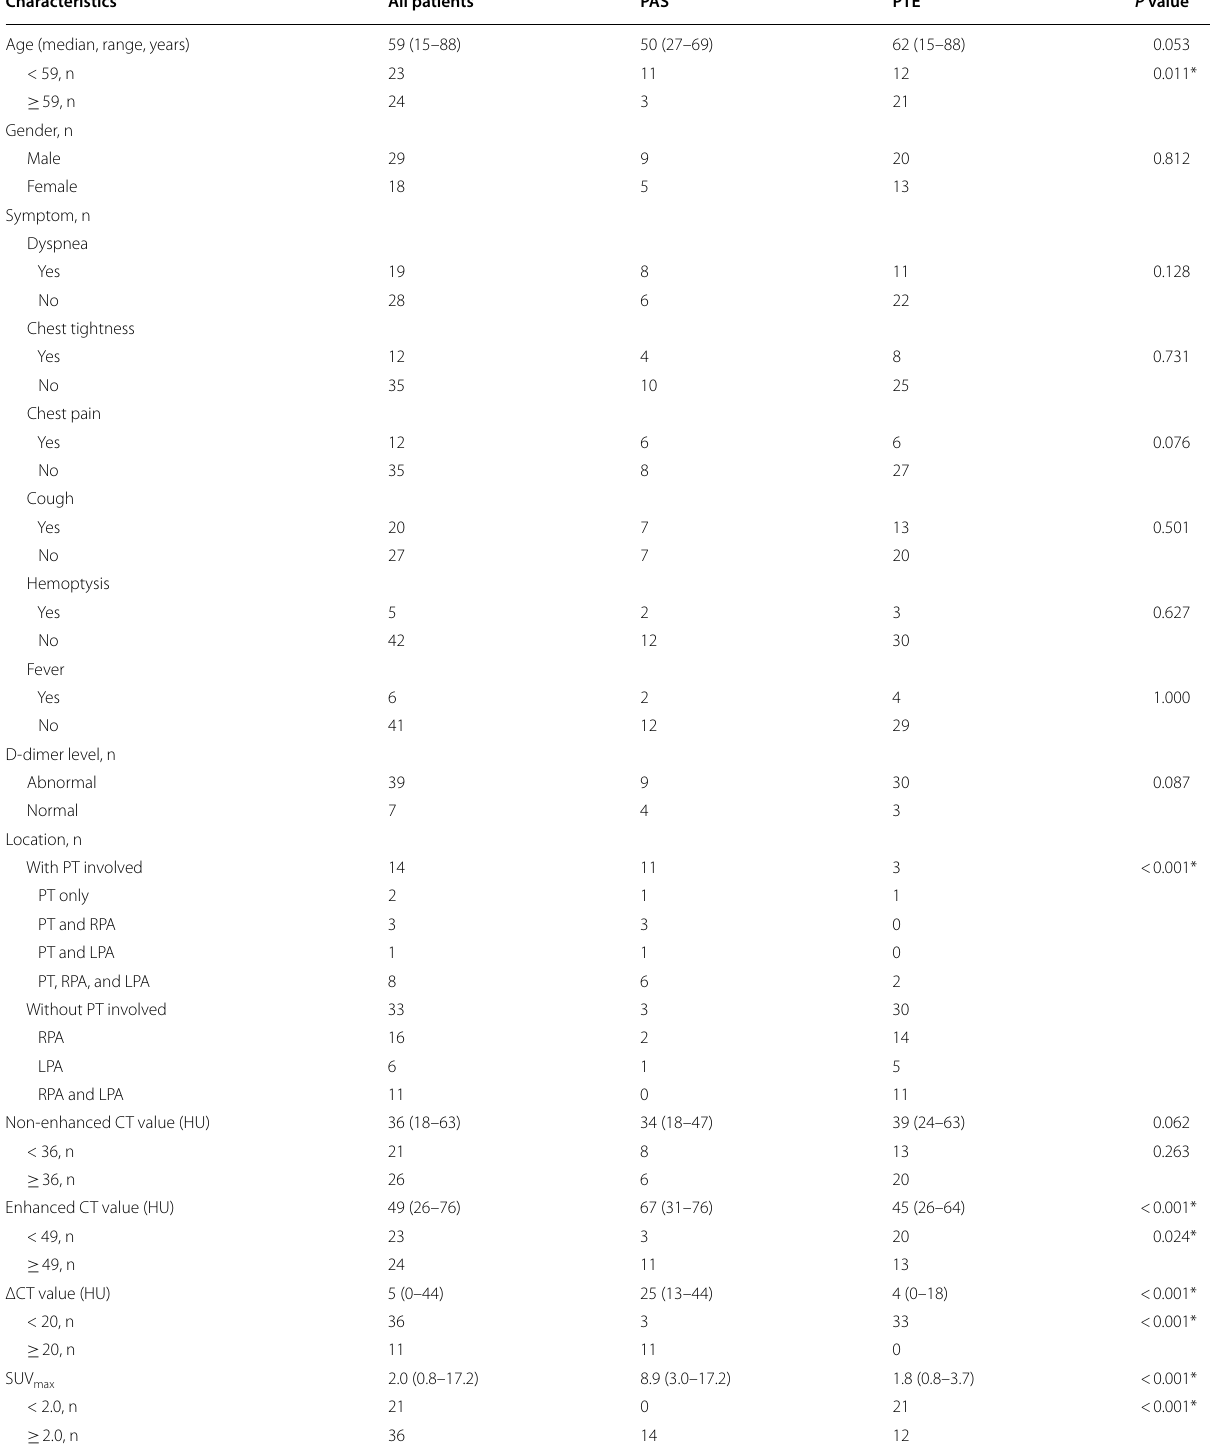
Table 1 Clinical, radiological, and PET/CT characteristics of the enrolled patients